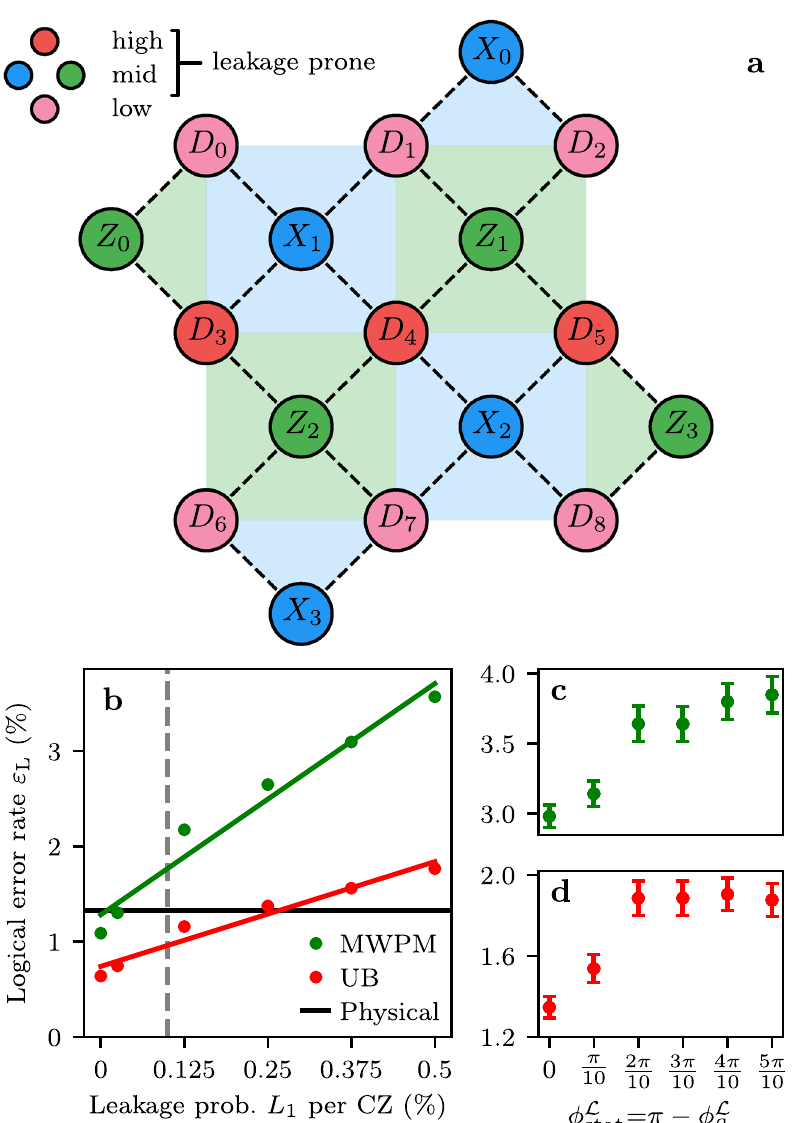
Fig. 2 The effect of leakage on the performance of Surface-17. a Schematic overview of the Surface-17 layout 46 . Pink (resp. red) circles with D labels represent low-frequency (high-) frequency data qubits, while blue (resp. green) circles with X ( Z ) labels represent ancilla qubits of intermediate frequency, performing X -type ( Z -type) parity checks. b Dependence of the logical error rate ε L on the leakage probability L 1 for a MWPM decoder (green) and for the decoding upper bound (red). The black solid line shows the physical error rate of a single transmon qubit. The dashed line corresponds to the recently achieved L 1 in experiment 9 . Logical error rate ε L for MWPM ( c ) and upper bound ( d ) as a function and ϕ L (for L 1 = 0.5%). Here, these phases are not randomized but fi xed to the given values across all of the leakage conditional phases ϕ L flux stat runs. The logical error rates are extracted from an exponential fi t of the logical fi delity over 20 QEC cycles and averaged over 5 batches of 2 × 10 4 runs for b and one batch of 2 × 10 4 runs for c , d Error bars correspond to 2 standard deviations estimated by bootstrapping (not included in b due the error bars being smaller than the symbol